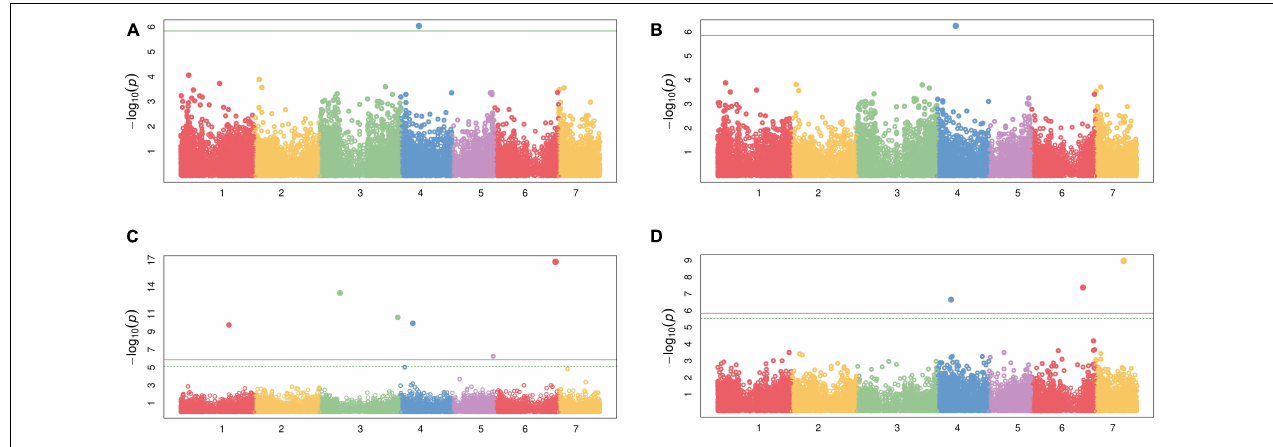
FIGURE 2 | Manhattan plot for the two forage quality traits using 105 diverse pearl millet hybrid parents (Set-III); (A) Crude protein (CP) at second cut for 2 years in combined analysis, (B) CP at second cut during summer season of 2016, (C) In vitro organic matter digestibility (IVOMD) at first cut during summer season 2015, and (D) IVOMD at second cut during summer seasons of